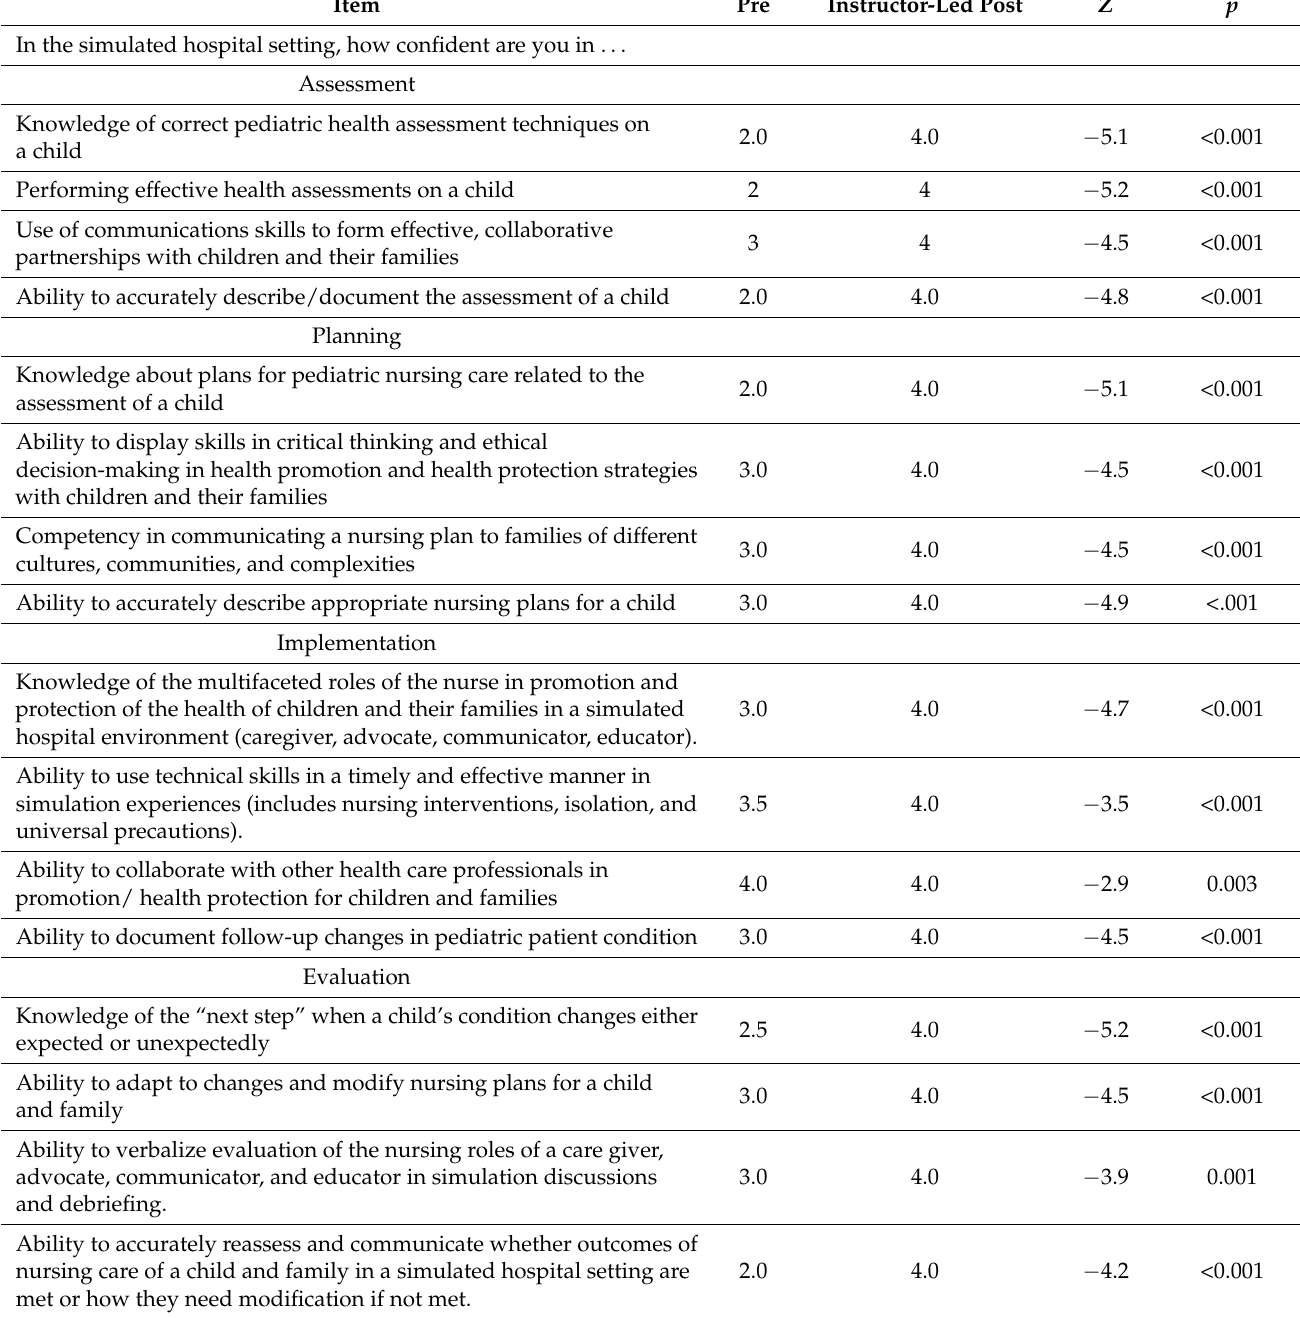
Table 4. Presurvey and Instructor-led Postsurvey Responses